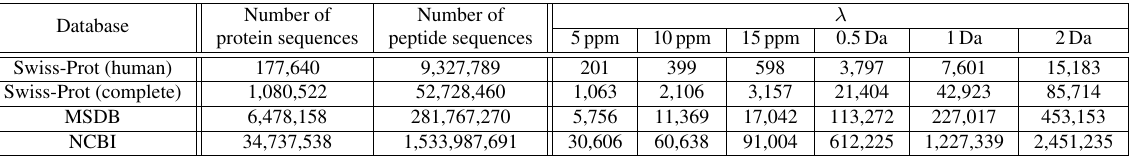
Table 3: Average numbers of comparisons of a query spectrum with theoretical spectra for dif- ferent protein sequence databases and different precursor mass error tolerances (cid:21) . Numbers of protein and peptide sequences in tested protein sequence databases are also proposed (the num- bers include also numbers of decoy sequences in the databases).